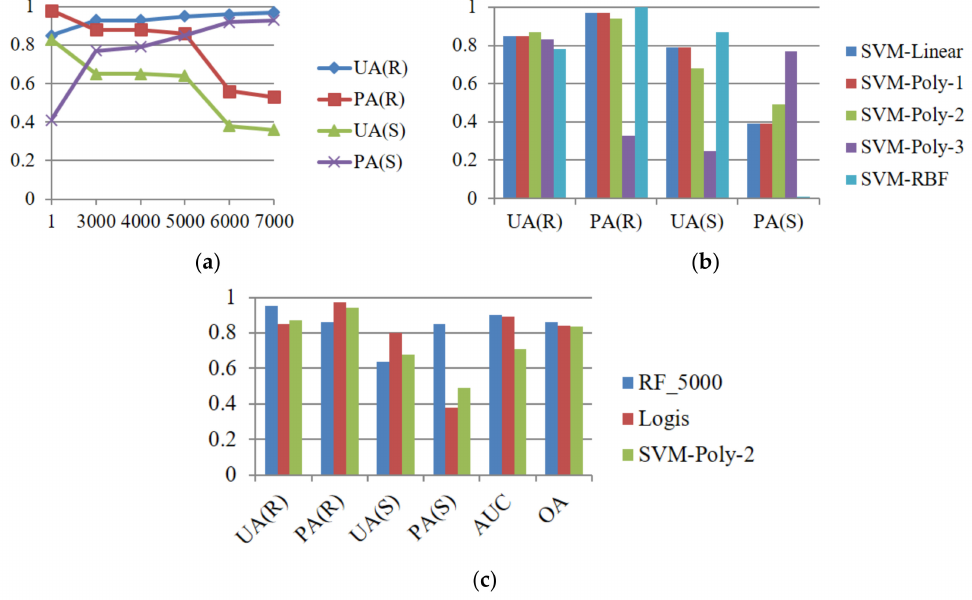
Figure 8. Performances ( Y -axis) of No. 1 model, where OA, AUC, PA, UA, S, and R represent the overall accuracy, area under the ROC curve, producer’s accuracy, user’s accuracy, landslide source, and runout, respectively. ( a ) Using the algorithm with the costs; ( b ) using the support vector machine (SVM) with linear, the first- to third-order polynomial, and radial basis (RBF) functions; ( c ) comparing the optimal results of ( a ) and ( b ) by using logistic (Logis)